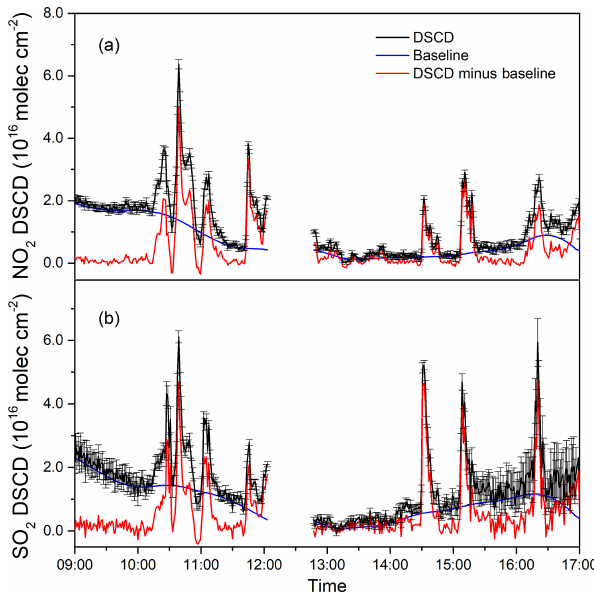
Figure 12. Diurnal variations of (a) NO 2 and (b) SO 2 DSCDs mea- sured at a 7 ◦ elevation angle on 26 June